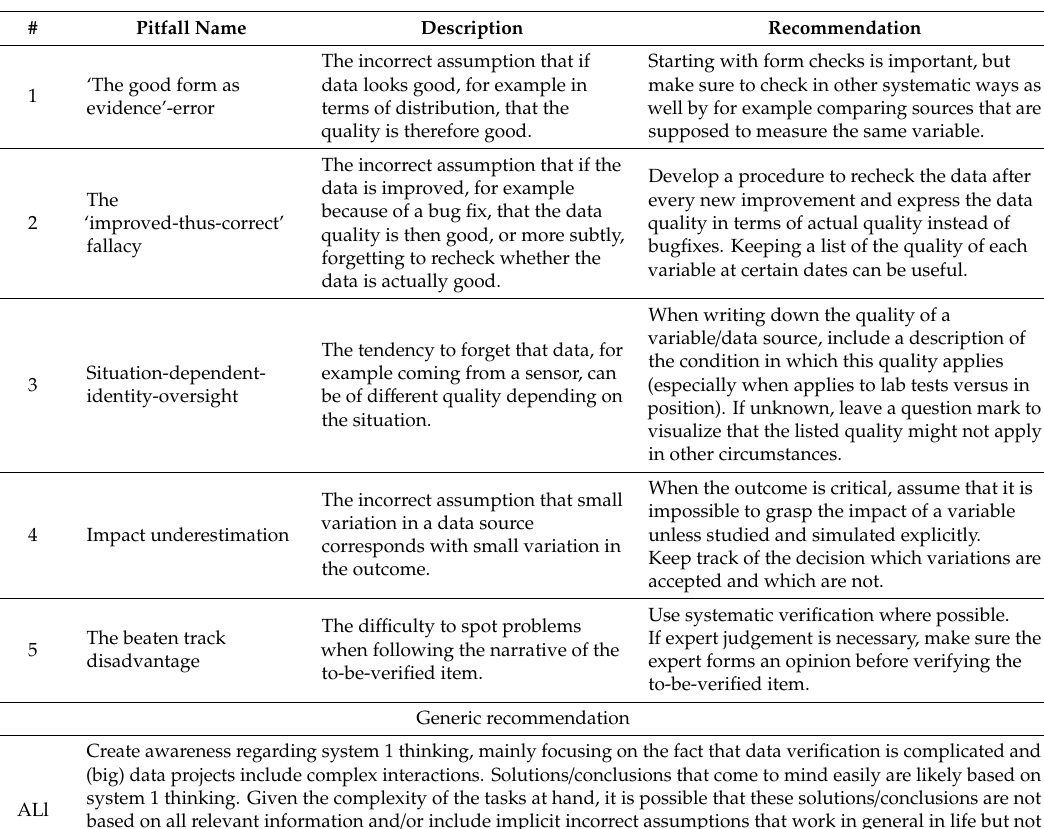
Table 1. Summary of the 5 identified